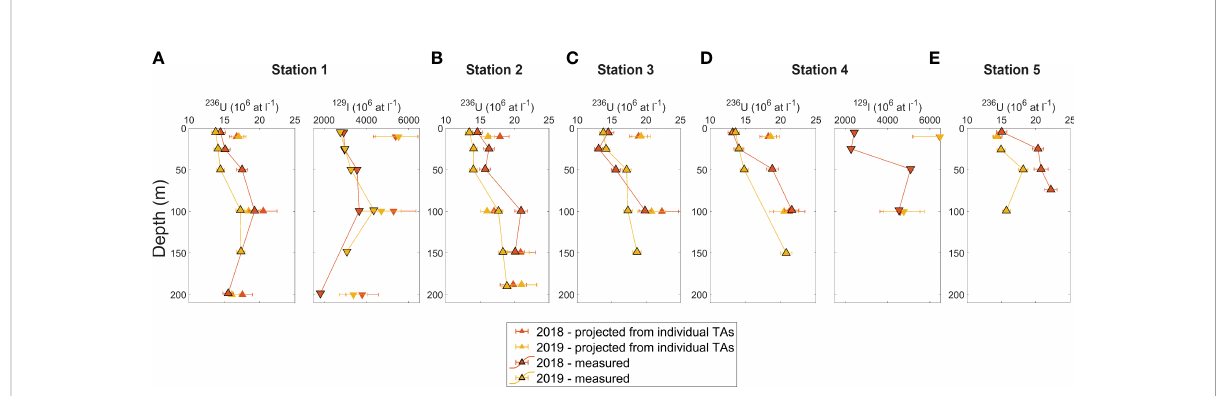
FIGURE 5 (A – E) Pro fi les of measured (data points with black outline) and projected (data points with no outline) 236 U (and 129 I for station 1 and 4) at matching stations for 2018 (red) and 2019